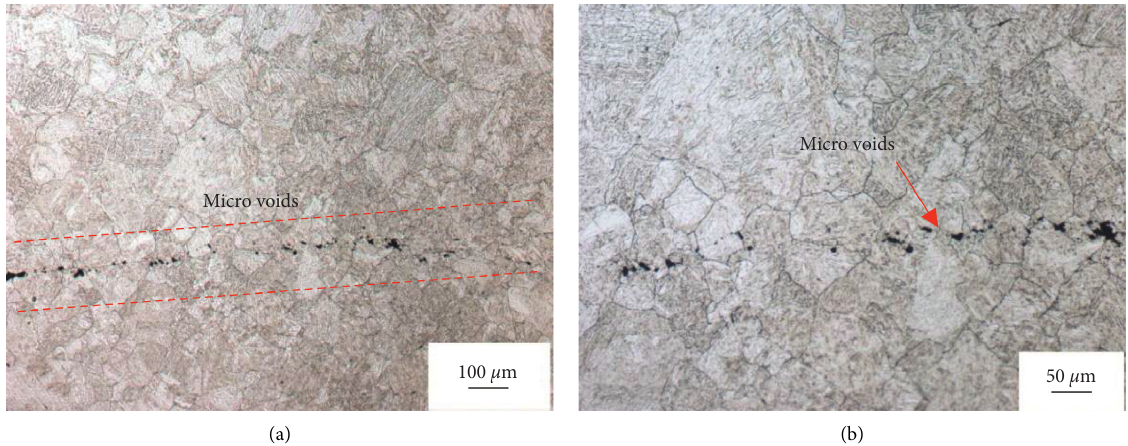
Figure 6: Microstructure of the crack healing zone at FR 1.8. (a) 100 times magnification. (b) 200 times